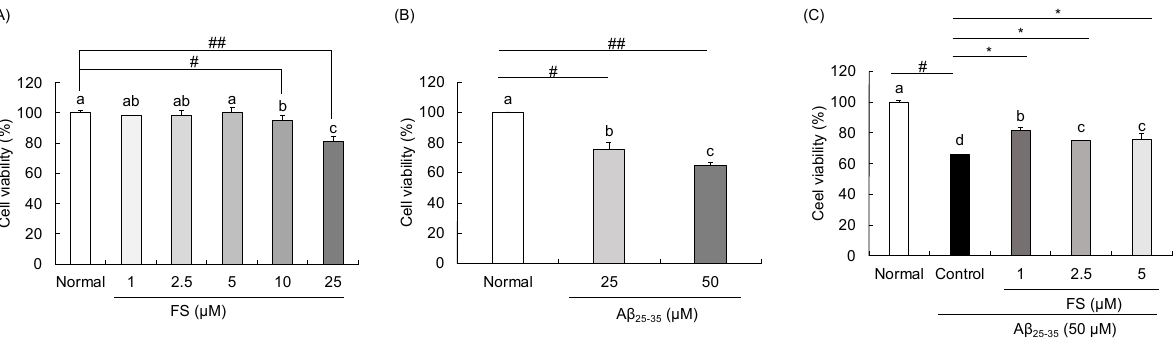
Figure 3. Effects of N -feruloyl serotonin on A β 25–35 -induced neuronal damage in SH-SY5Y cells. ( A ) Cell viability of FS (1, 2.5, 5, 10, 25 µM). ( B ) Cell viability of A β 25–35 (25, 50 µM). ( C ) Cell viability of FS (1, 2.5, 5 µM) with A β 25–35 (50 µM). Values present means ± SD ( n = 5). a–d Means with different letters are significantly different ( p < 0.05) by Duncan’s multiple range test. # p < 0.01, ## p < 0.0001 vs. normal; * p < 0.05 vs. control. FS, N -feruloyl serotonin.